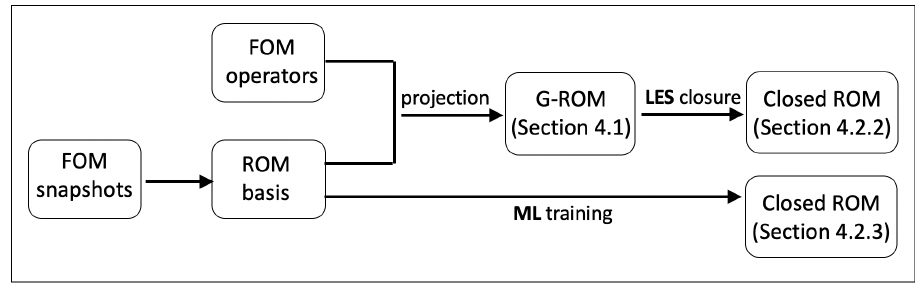
Figure 3. Framework of the ROMs presented in Section